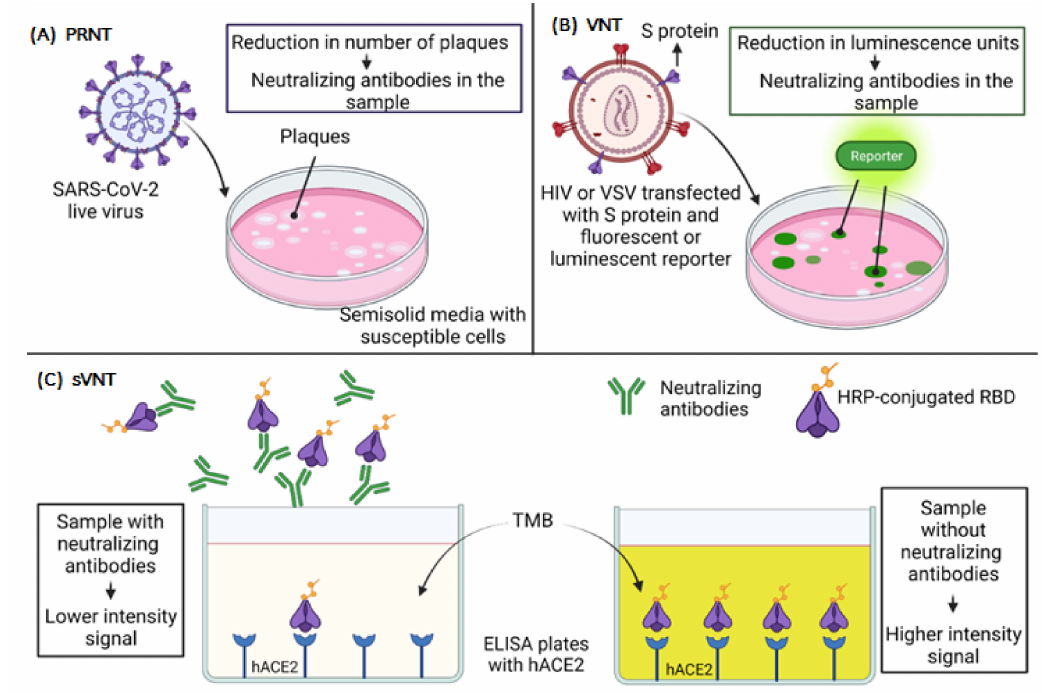
Figure 4. Neutralization assays. ( A ) In a PRNT assay, cells susceptible to infection are cultured in semi-solid media and are infected with the SARS-CoV-2 live virus. The semi-solid media allow that the infection to be localized and can be visualized as plaques. The plaques are counted, and a reduction in the number of plaques means that there are neutralizing antibodies in the sample. ( B ) VNT is similar to a PRNT, but instead of a live virus, a virus-like HIV or VSV is transfected with the S protein of SARS-CoV-2 and a luminescent reporter. The luminescence units are sites of infection, and a reduction in luminescence units means that neutralizing antibodies are present. ( C ) The sVNT uses an immobilized hACE2 in ELISA plates and an HRP-conjugated RBD; if neutralizing antibodies are present in the sample, the HRP-conjugated RBD will not bind to hACE2, and there will be no or lower intensity signal. PRNT, plaque reduction neutralization test; VNT, virus neutralization test; sVNT, surrogate virus neutralization test; HIV, human immunodeficiency virus; VSV, vesicular stomatitis virus; hACE2, human angiotensin-converting enzyme 2; HRP, horseradish peroxidase; RBD, receptor-binding domain; TMB,